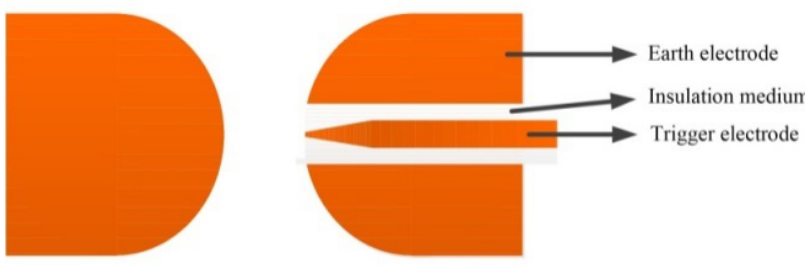
Figure 5. Schematic diagram of the trigger switch.